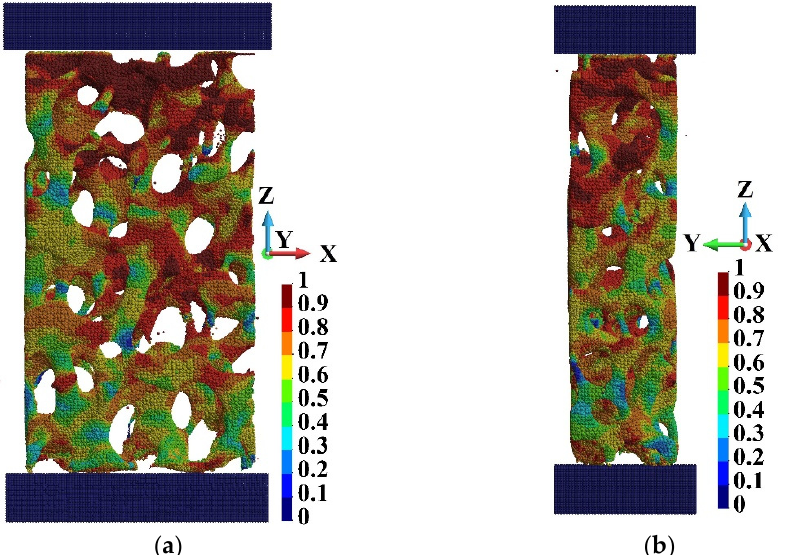
Figure 15. Damage distribution and shape of the foam under piston velocity 40 m/s at the end of the process: ( a ) X-Z plane view; ( b ) Y-Z view.